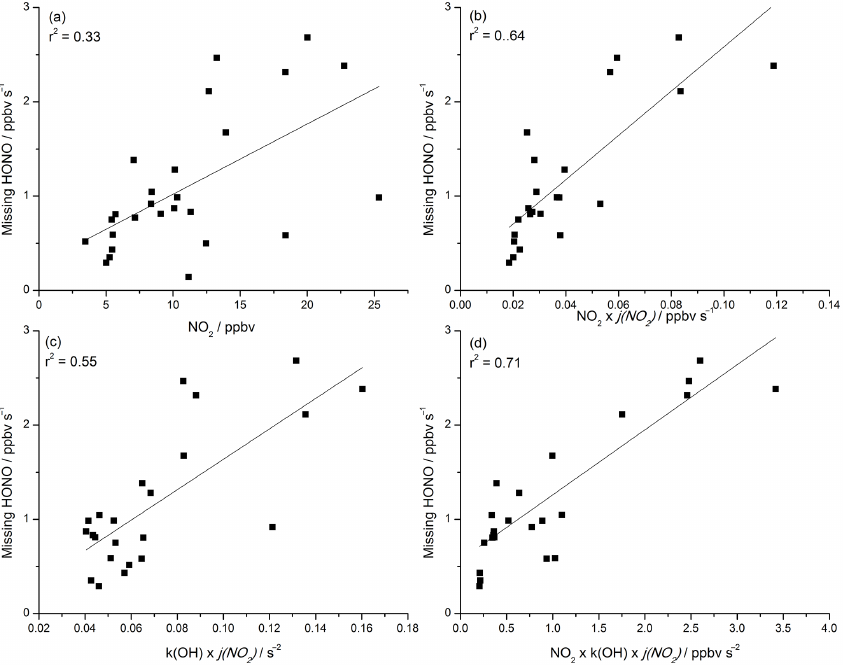
Figure 8. Daytime averaged (08:00–19:00UTC) missing HONO source plotted against (a) NO 2 , (b) NO 2 × j (NO 2 ), (c) k (OH) × j (NO 2 ), and (d) NO 2 × k (OH) × j (NO 2 ).